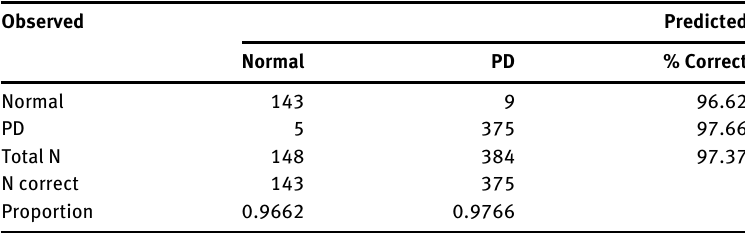
Table 4: Classification Table.